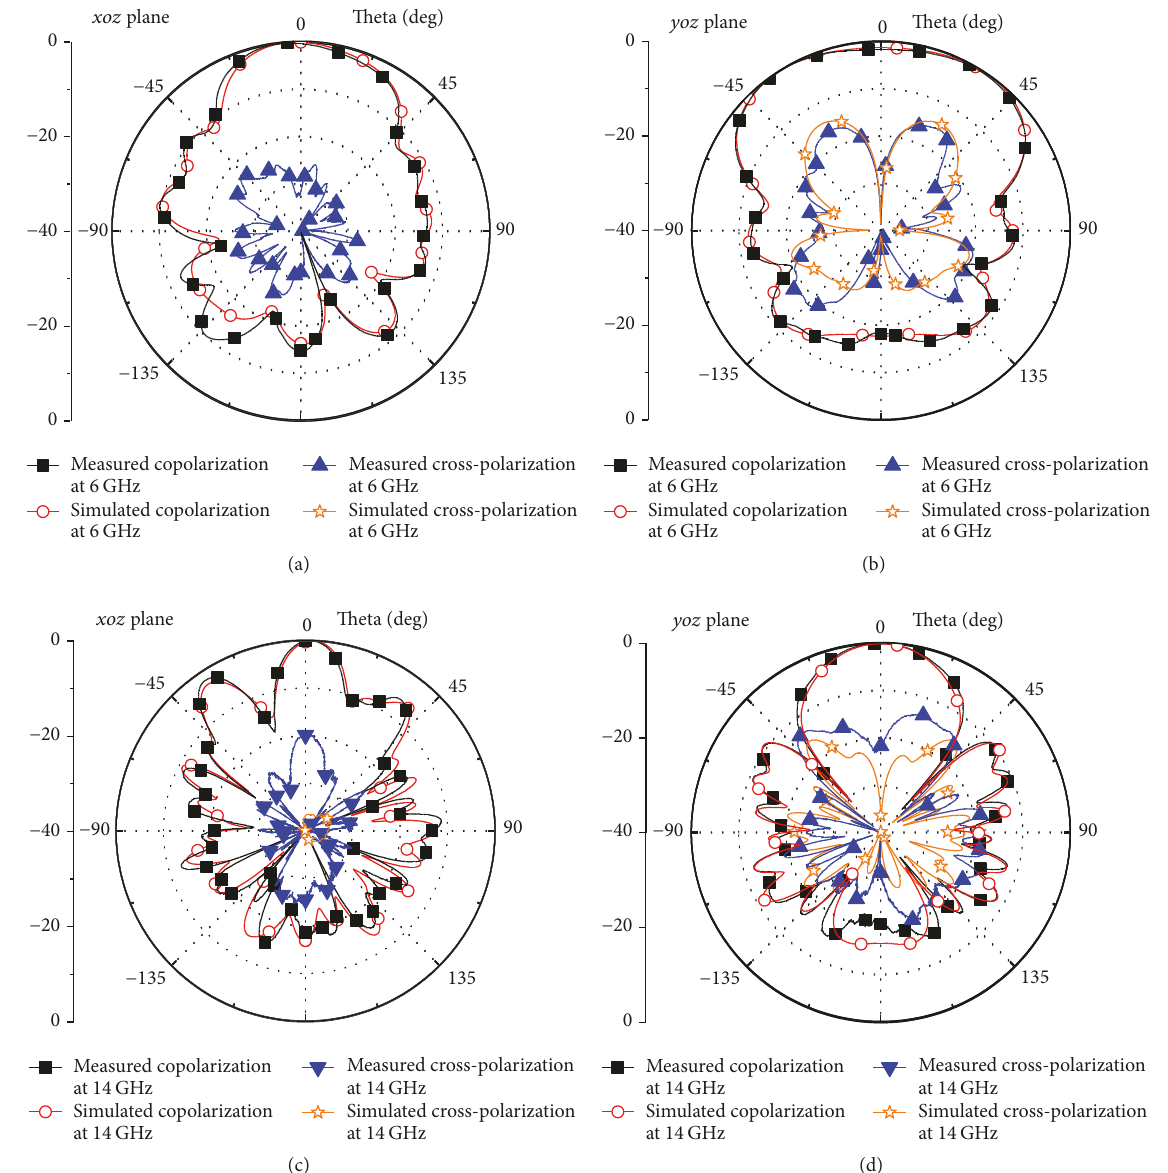
Figure 7: Simulated and measured radiation patterns. (a) Patterns in E -plane at 6GHz, (b) patterns in H -plane at 6 GHz, (c) patterns in E -plane at 14GHz, and (d) patterns in H -plane at